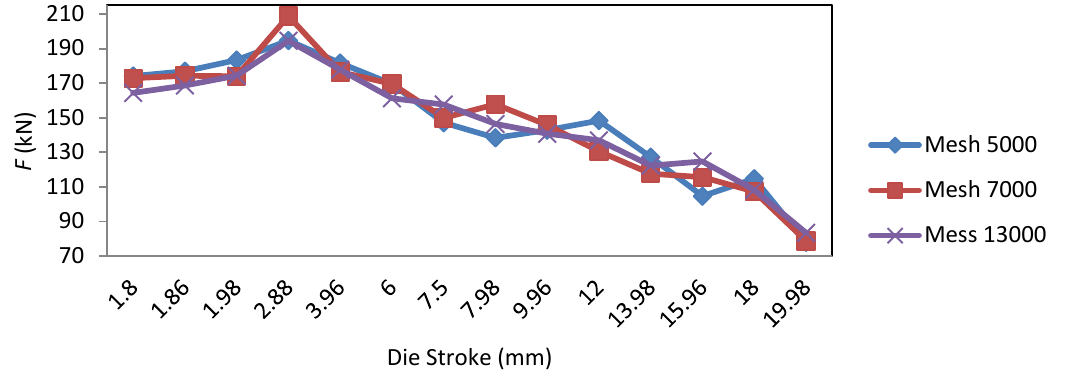
Figure 3. Extrusion force for different mesh sizes.